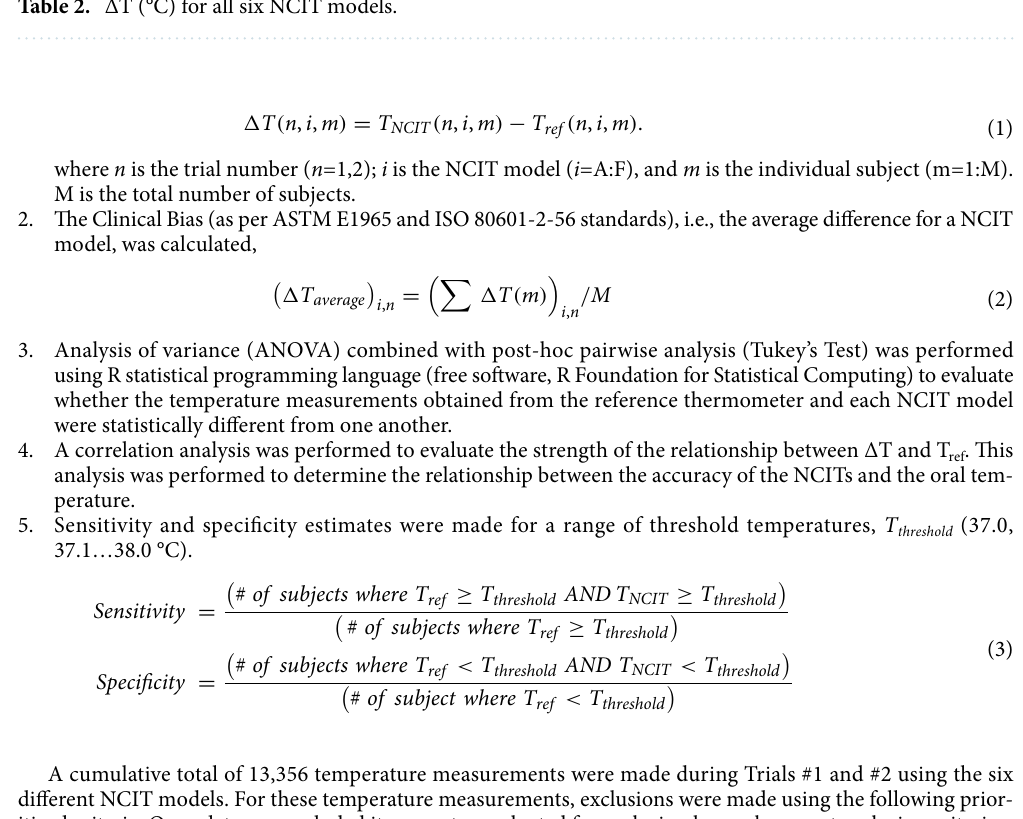
Table 2. ΔT (°C) for all six NCIT